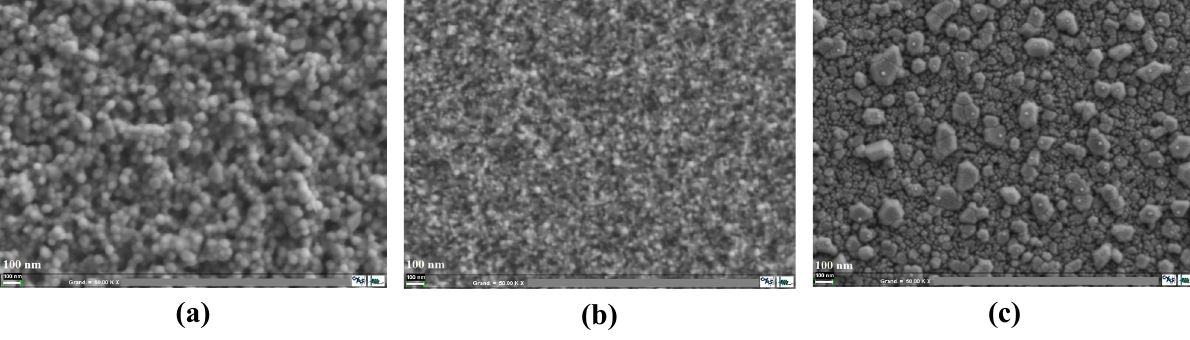
Figure 3. SEM images of 7-layer ZnO thin films: ( a ) undoped, ( b ) 1 at.% Al-doped, ( c ) 2 at.%